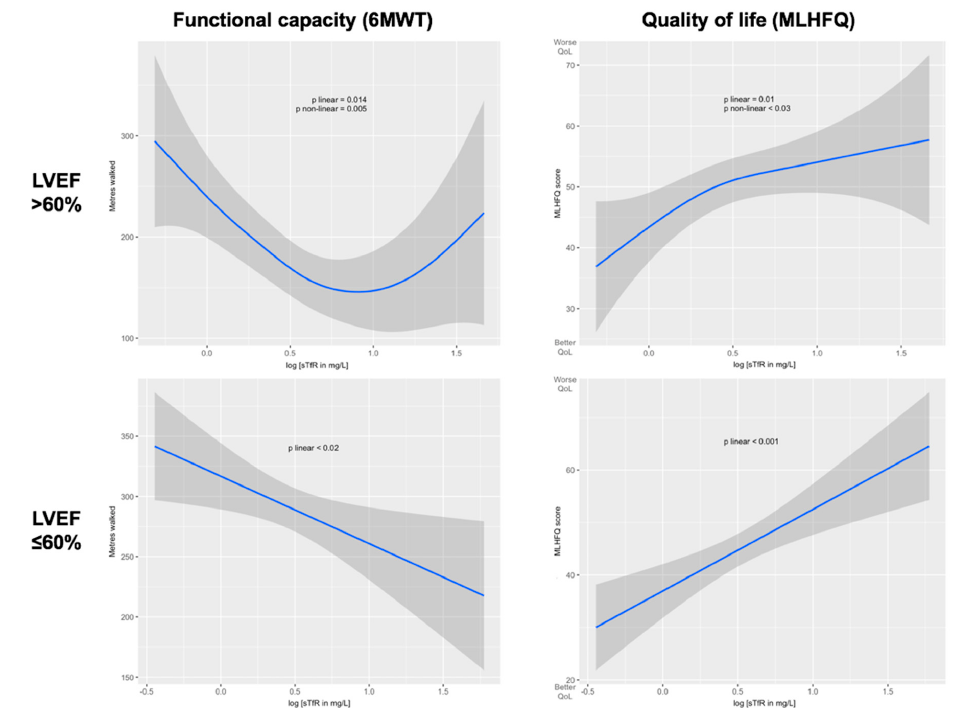
Figure 3. Unadjusted associations between sTfR (log-transformed) and functional capacity and quality of life, separated by LVEF > 60% or ≤ 60%, and calculated using generalized additive models (GAM). 6MWT (6-min walking test), LVEF (left ventricular ejection fraction), MLHFQ (Minnesota Living with Heart Failure Questionnaire), sTfR (serum soluble transferrin receptor).